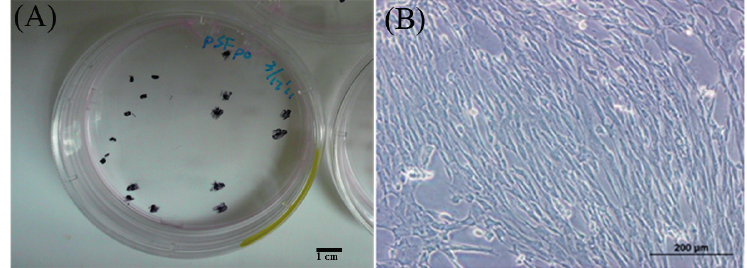
Figure 1. ( A ) Cell colonies of synovial fluid mesenchymal stem cells (SF-MSCs) after a 10-day cultivation; ( B ) The morphology of SF-MSCs. Three SF-MSCs samples were performed for this experiment.